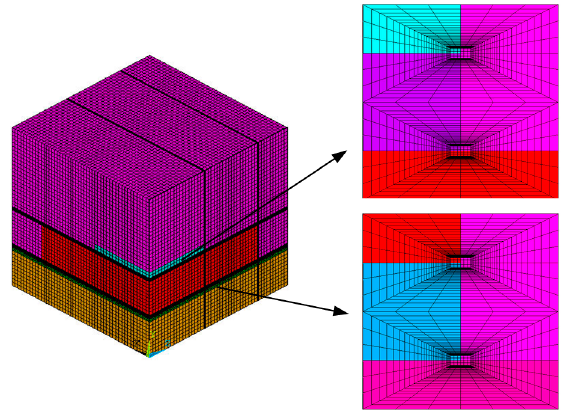
Figure 6. FEM model of chip Q2.